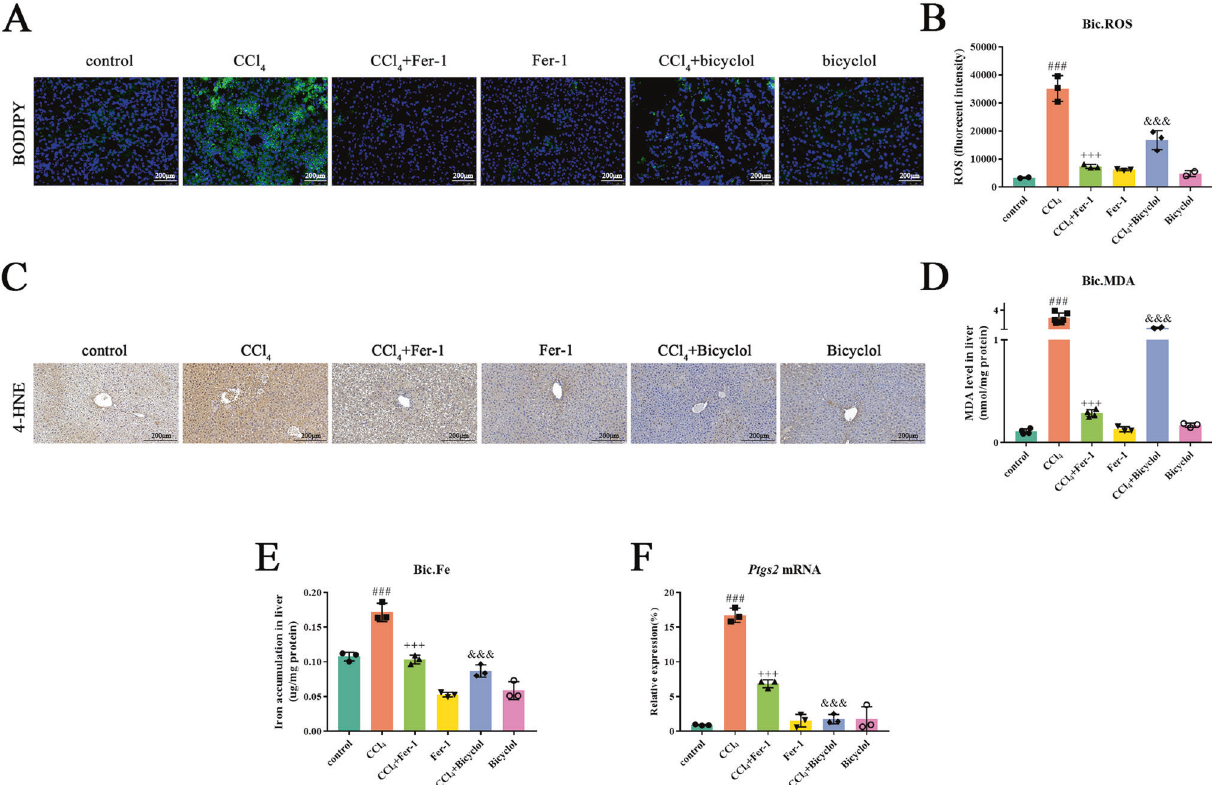
Fig. 3 Bicyclol mitigates CCl 4 -induced ferroptosis process in vivo. A The accumulation of lipid peroxidation were analyzed by 581/591 C11- BODIPY in liver tissue. B Hepatic ROS content was assessed. C 4-HNE protein adducts expression was measured in fi xed liver tissue sections. D The content of MDA in the liver tissues was evaluated. E Hepatic iron concentration was assessed. F Ptgs2 mRNA levels were determined by real-time PCR analysis. Data were expressed as mean ±SD. ### p <0.001 vs control group, +++ p < 0.001 vs CCl 4 group, &&& p <0.001 vs CCl 4